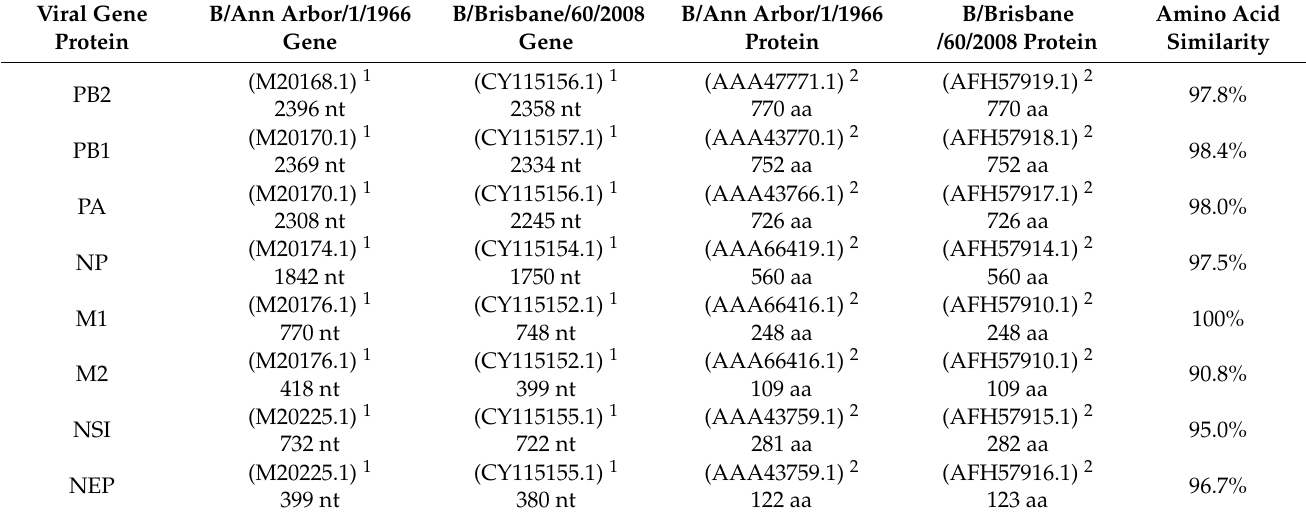
Table 1. Nucleotide and amino acid sequence comparison of B/Ann Arbor/1/1966 and B/Brisbane/60/2008. Viral Gene